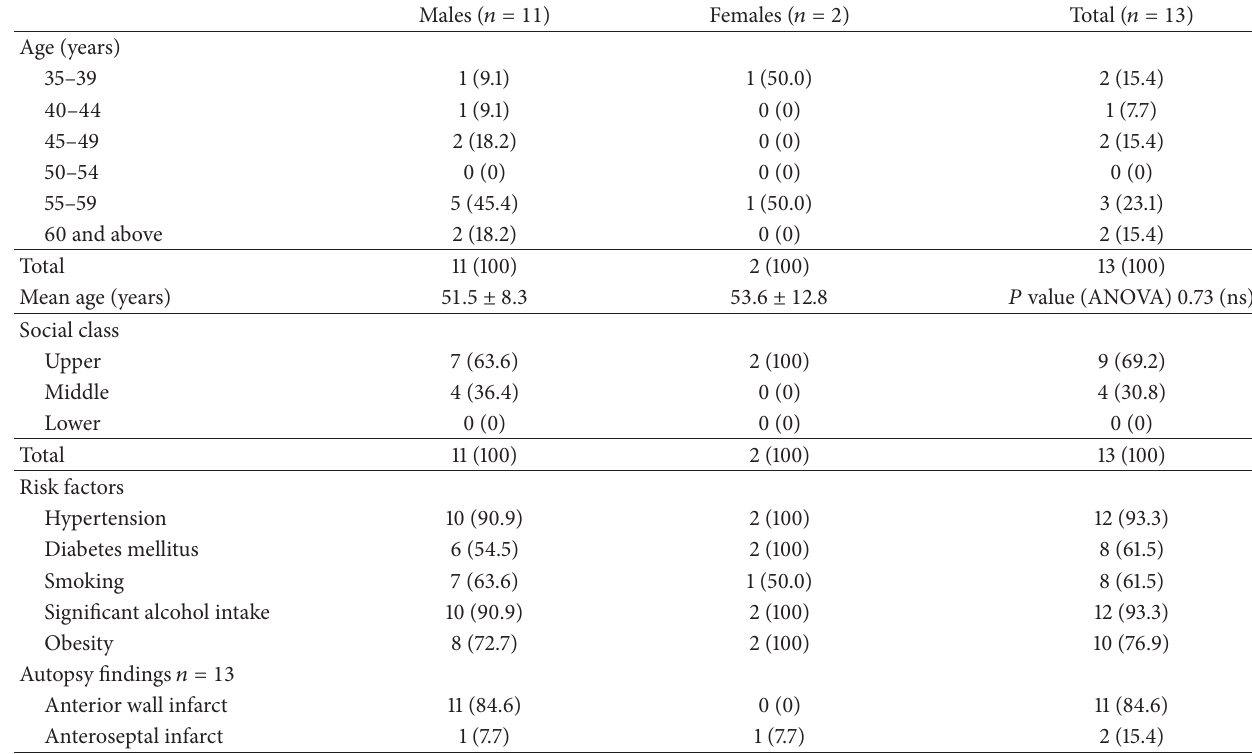
Table 2: Sociodemographic and autopsy findings of the coroner’s